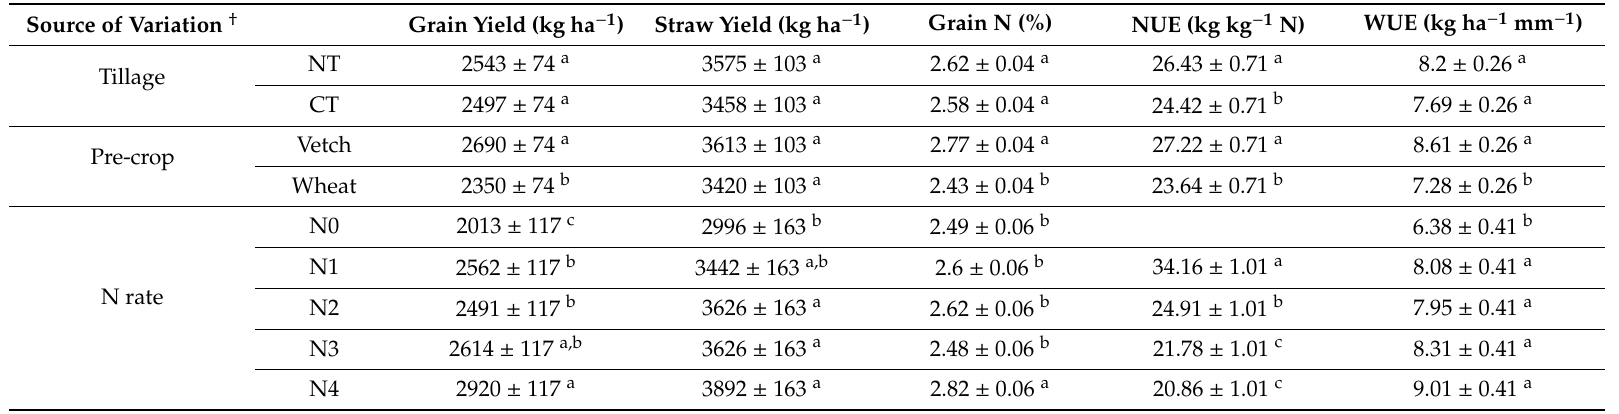
Figure 2. Effect of the two-way interactions of Tillage × Pre-crop (up) and Tillage × N rate (down) on ( a ) and ( a’ ) grain yield, ( b ) and ( b’ ) straw yield, ( c ) and ( c’ ) nitrogen content in grain, ( d ) and ( d’ ) nitrogen use efficiency (NUE), and ( e ) and ( e’ ) water-use efficiency in grain (WUE). Data are averages ± standard errors. Different lowercase letters indicate significant differences between all treatments in each item ( p < 0.05). Table 3. Grain yield, straw yield, N content in grains (Grain N), N use efficiency (NUE), and water-use efficiency (WUE) as affected by tillage practice (CT and NT), previous crop (bread wheat and vetch), and nitrogen rate (N0, N1, N2, N3, and N4). Data are averages ± standard errors. Different lowercase letters indicate significant differences between all treatments in each item ( p < 0.05). † Tillage, tillage practice; Pre-crop, previous crop; N rate, nitrogen rate. Source of Variation